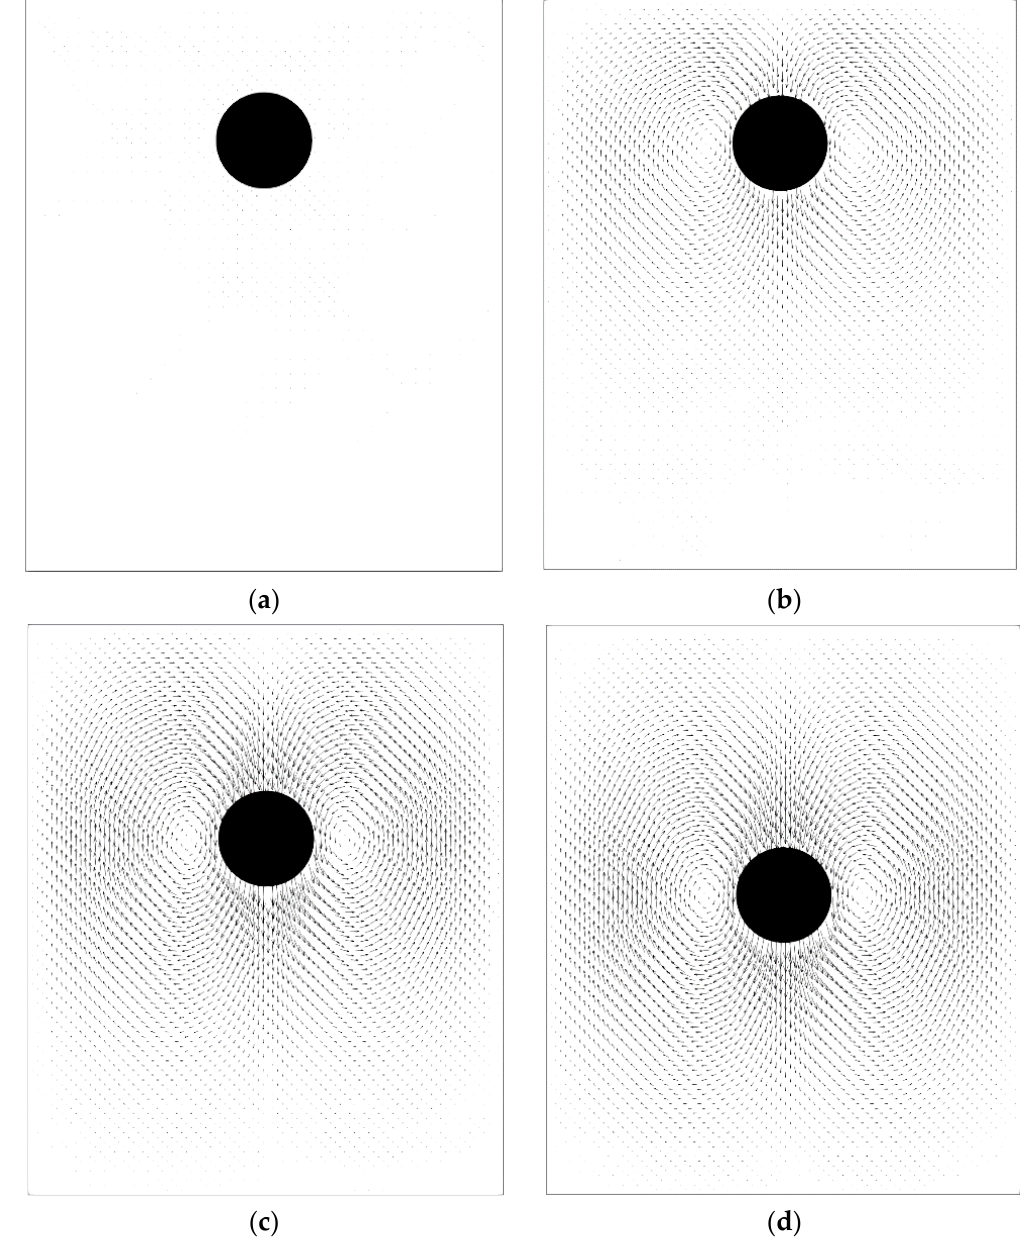
Figure 13. Sinking particle’s location and change in velocity with time wherein two eddies appear at the symmetry sides as the particle moves: ( a ) time step = 0; ( b ) time step = 20; ( c ) time step = 300; ( d ) time step = 500.